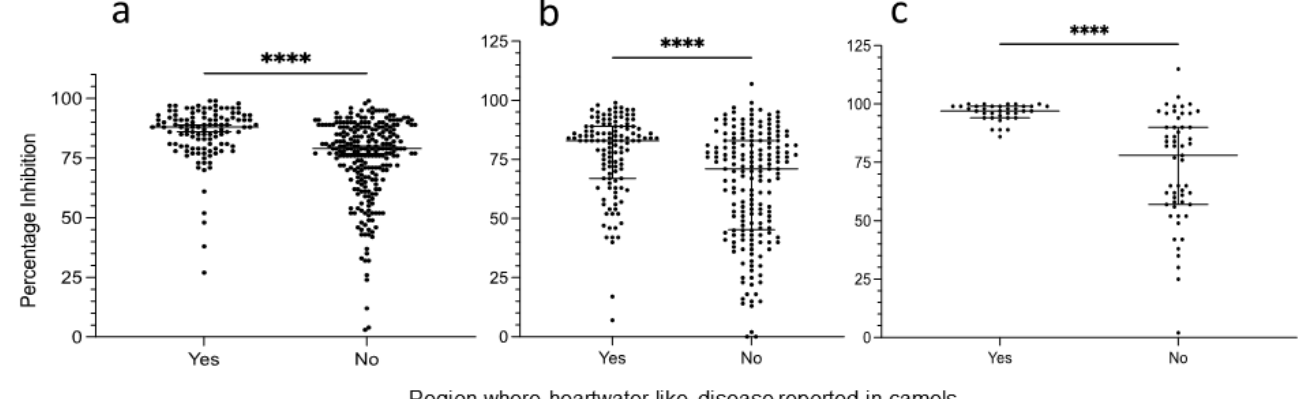
Figure 4. Comparison of PC-ELISA percentage inhibition (PI) values for camels and sheep collected in or originating from areas of Kenya where heartwater-like disease in camels was reported in 2016 (Yes) with areas of Kenya where such disease was not reported (No); ( a ) camels sampled in 2015 at Isiolo ( n = 143) and Athi River slaughterhouse ( n = 230); ( b ) camels sampled during the present study in 2020 in Marsabit, Laikipia, and Machakos counties ( n = 306); ( c ) sheep sampled during the present study in 2020 ( n = 90). In all groups, median PI was significantly higher in animals sampled in, or originating from, areas where heartwater-like disease was reported in 2016. Graphs include all data points with median value shown by widest horizontal line. Data were analysed in a two-tailed Mann – Whitney test; **** p < 0.0001.